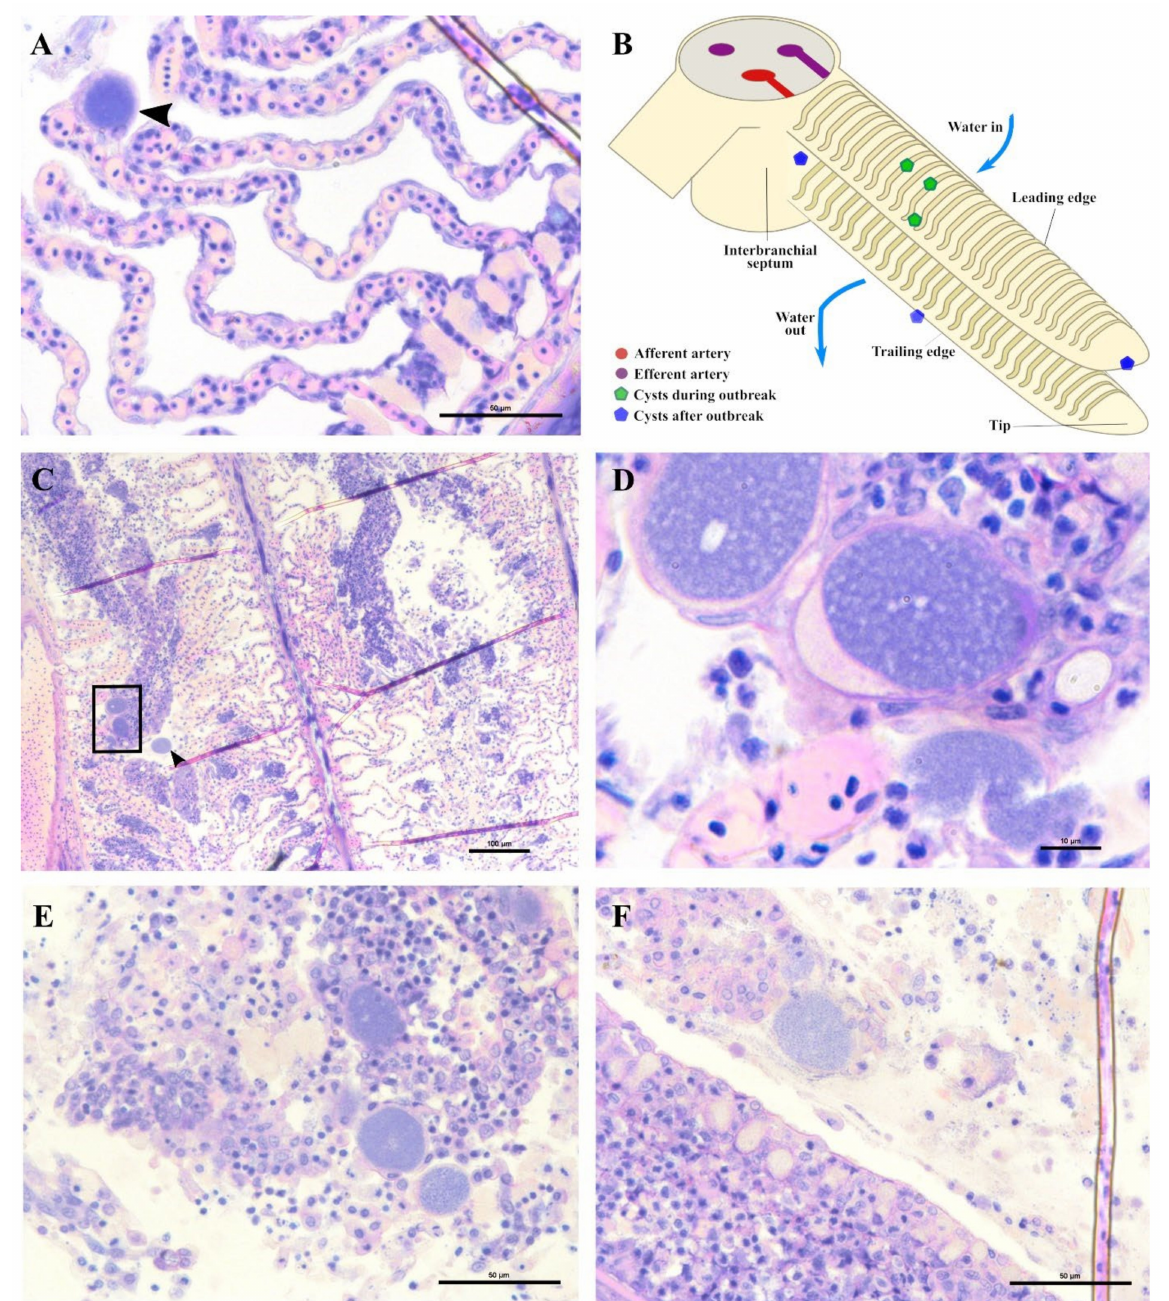
Figure 9. Monitoring of epitheliocystis in the months following the outbreak (cohort 2018). Poly- chrome stain of greater amberjack gills. ( A ) Cyst on the tip of the lamella, January 2019. ( B ) Illustration of a segment of the branchial arch showing the direction of the water flow and the different areas of the filament on which cysts were located during the outbreak (green stars) and after the outbreak (blue stars). ( C ) Cysts on the mucosa of the interbranchial septum, January 2019. ( D ) Higher mag- nification from the framed area of picture C. ( E ) Cysts on the tip of the filament, November 2018. ( F ) Cysts on the trailing edge of the filament, December